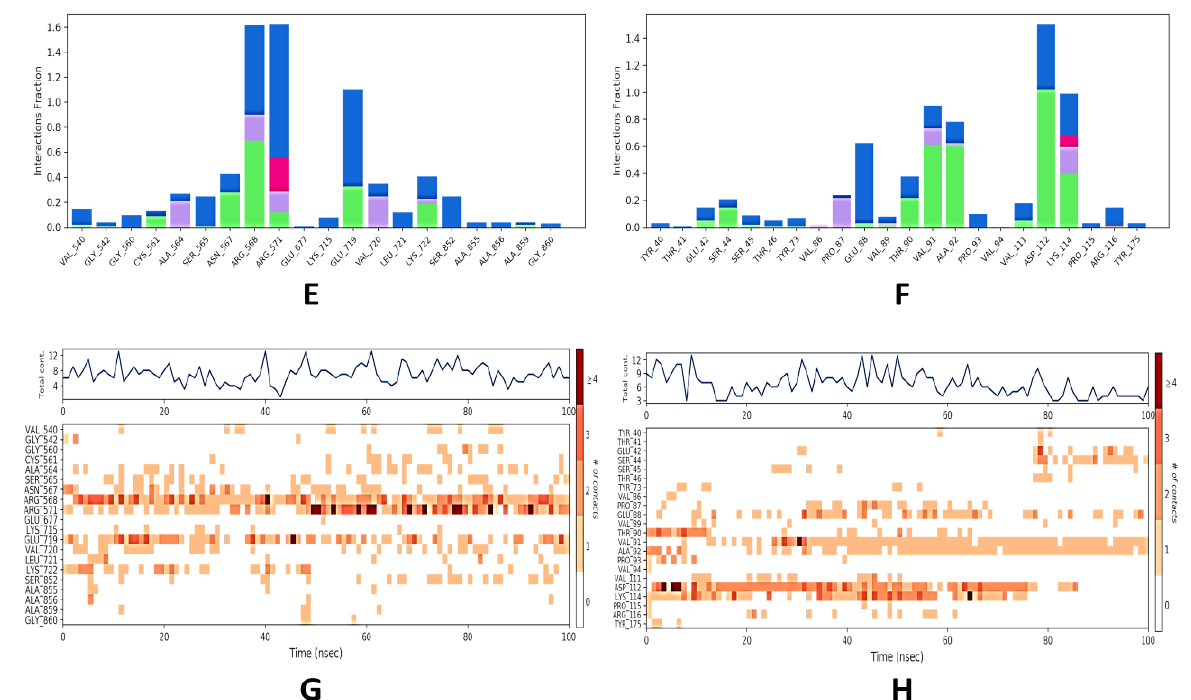
Figure 5. Protein–ligand interaction profile of protein–ligand complexes. ( A ) Interaction profile of crucial interacting amino acids of 4YAY with casuarinin. ( B ) Interaction profile of crucial interacting amino acids of 4DLI with casuarinin. ( E ) Interaction profile of crucial interacting amino acids of 1HW9 with casuarinin. ( F ) Interaction profile of crucial interacting amino acids of 1B09 with casuarinin. ( C ) Timeline representation of the interactions of amino acids of 4YAY with casuarinin, ( D ) timeline representation of the interactions of amino acids of 4DLI with casuarinin, ( G ) timeline representation of the interactions of amino acids of 1HW9 with casuarinin, ( H ) timeline representation of the interactions of amino acids of 1B09 with casuarinin. Different types of bar color indicate different types of bonds: hydrogen bond (green), hydrophobic contacts (purple), and water-bridge (blue). # in the graphs indicates total number of specific contacts.